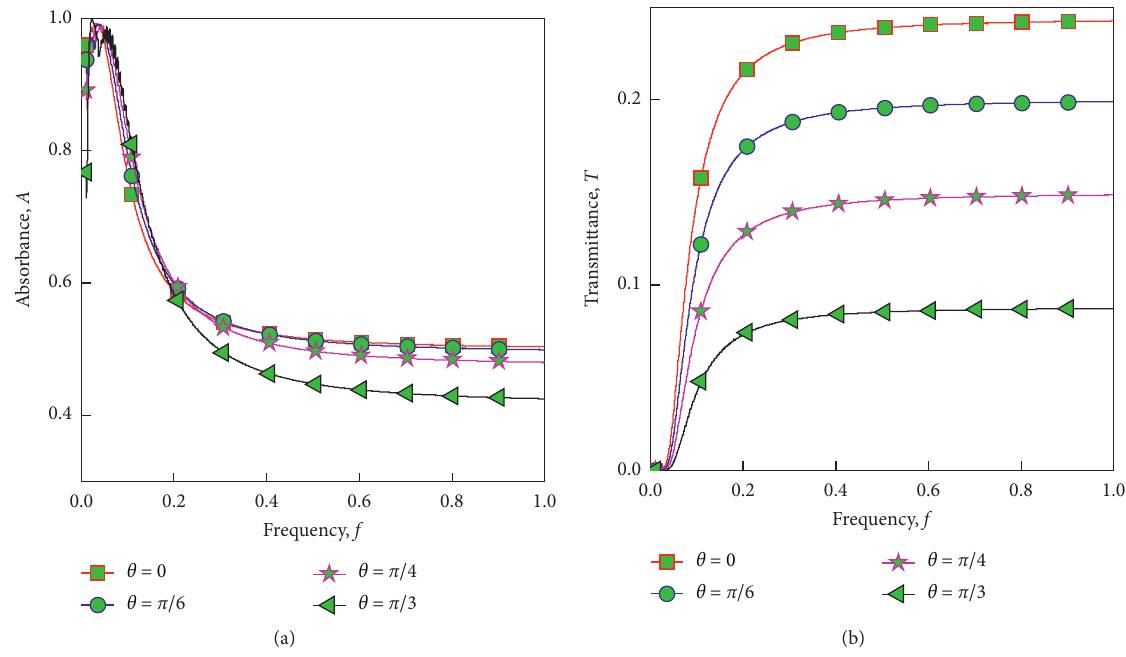
Figure 3: Absorbance and transmittance versus wave frequency for different incident angles in a dusty plasma